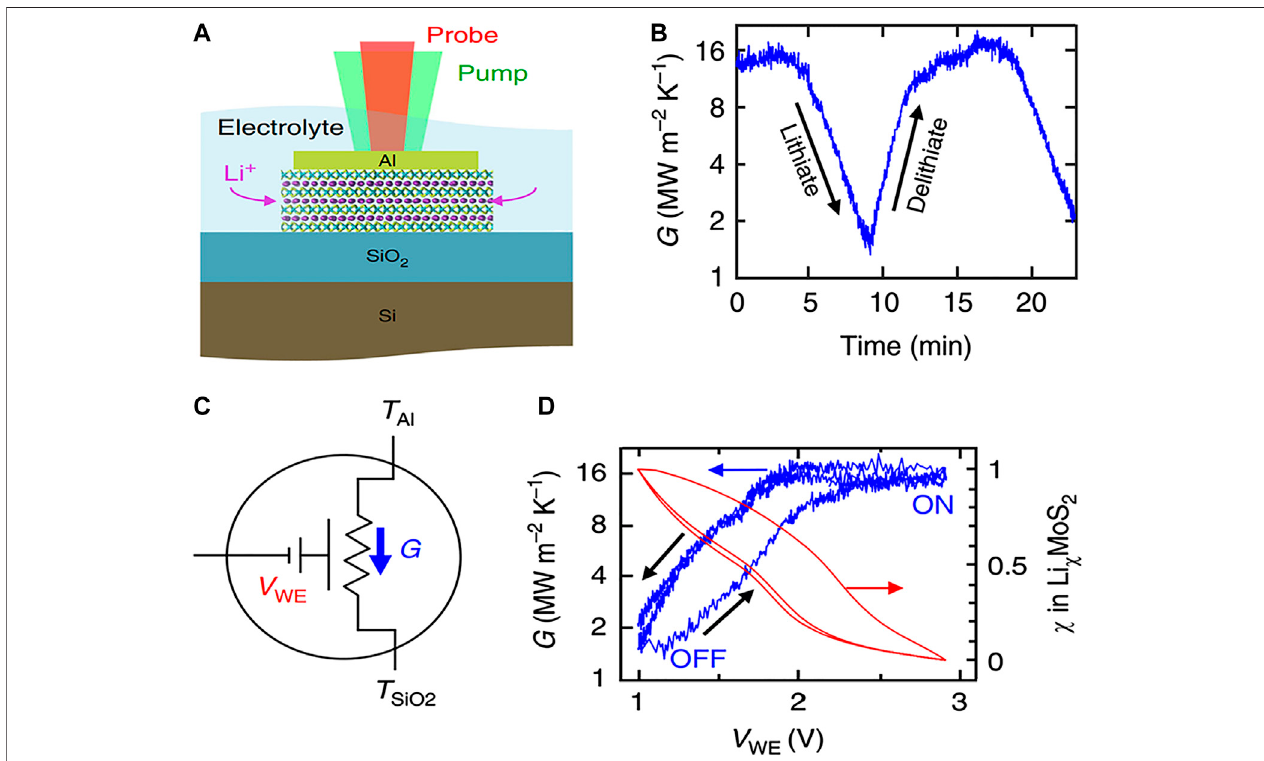
FIGURE10|(A) Theworkingprincipleofsuch device. (B) Themeasurement ofcross-planethermal conductance during the electrochemicalcycle, (C) The gating voltageV WE thatisappliedbetweenLiandAl/MoS 2 electrodeschangesthethermalconductanceG. (D) Thermalconductanceandaveragelithiumcomposition χ plotted as a function of voltage, indicating signi fi cant hysteresis between charge and discharge curves. Reproduced from (Sood et al., 2018) with permission from Nature Publishing